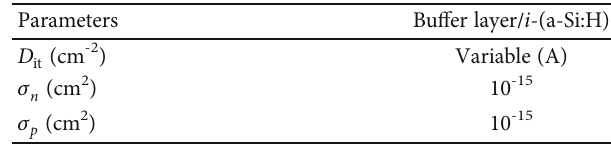
SC , (b) V OC , (c) Table 3: Properties of bu ff er layer/absorber layer